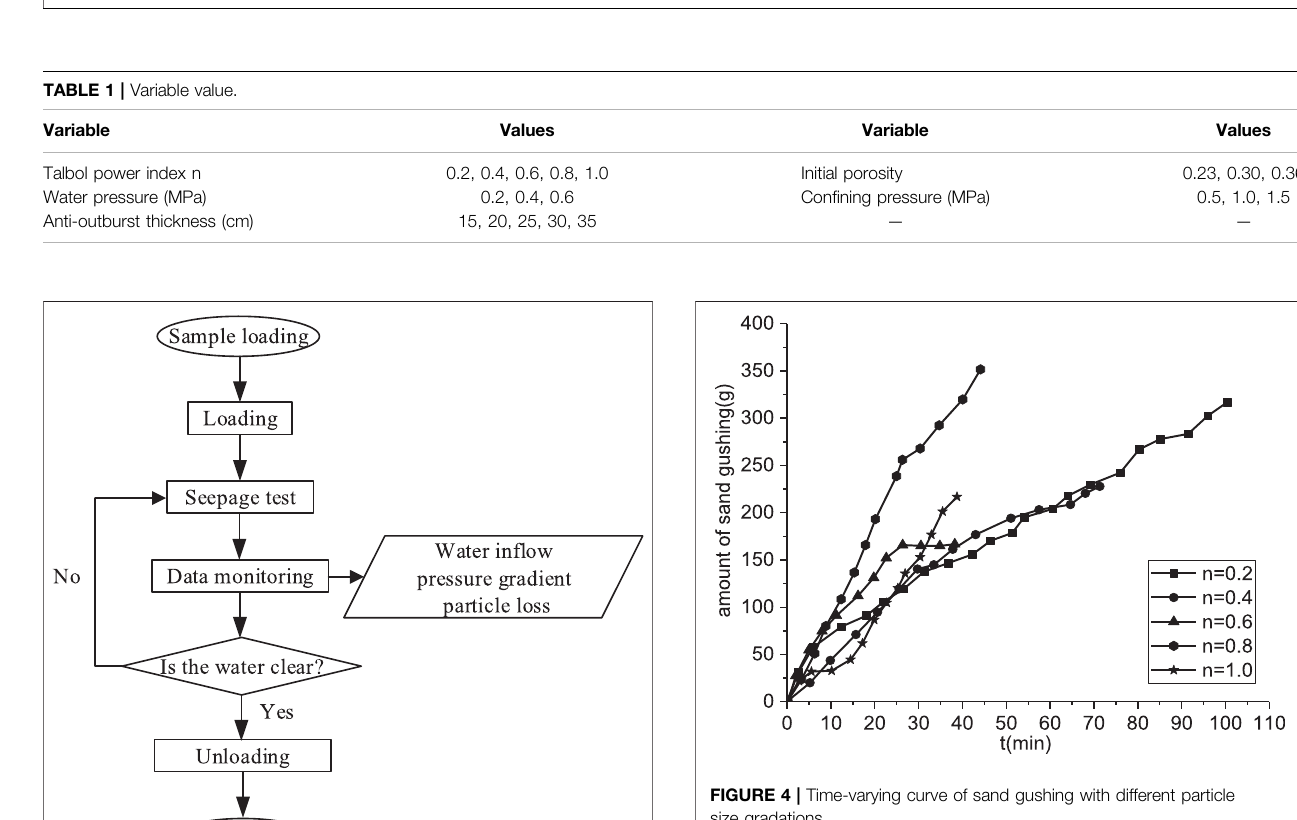
FIGURE 2 | Particle size distribution curve: (A) particle size distribution curve before and after water bursting and (B) particle size distribution curve with different Talbol power exponents.